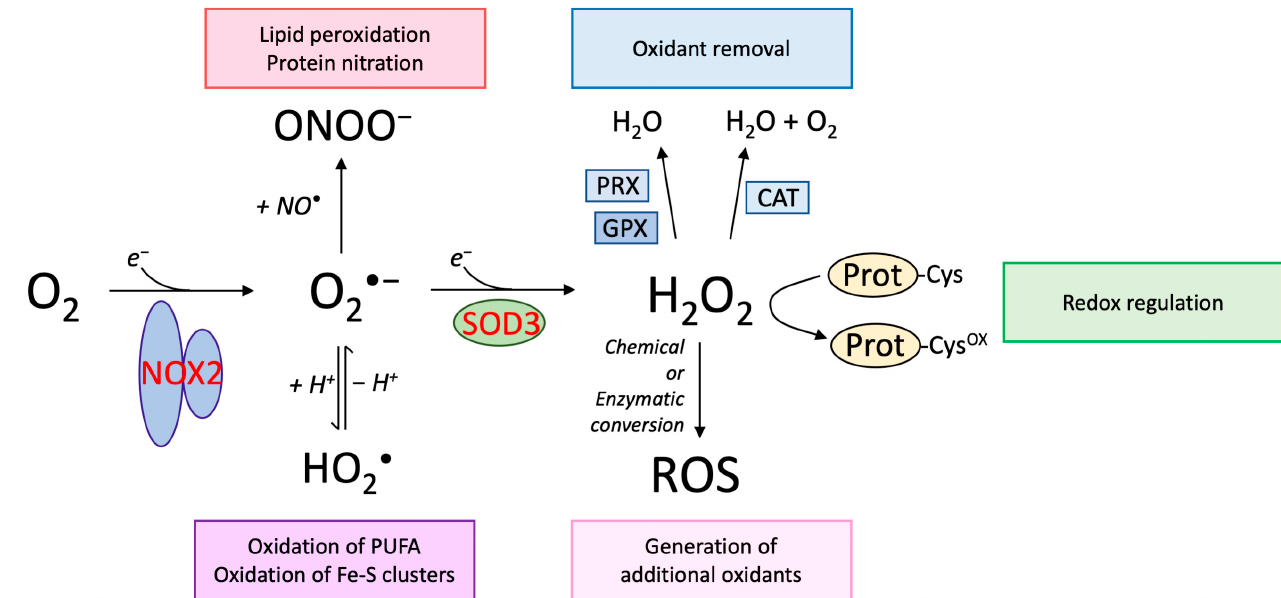
Figure 1. Biological impact of superoxide and hydrogen peroxide. The univalent reduction of molecular oxygen (O 2 ) generates the superoxide radical (O 2 •− ) and is enzymatically catalyzed by the NOX protein family, including NOX2. In biological systems at a physiological pH, superoxide is in equilibrium with the perhydroxyl radical, representing the protonated form of superoxide. Although the perhydroxyl radical only represents below 1% of superoxide at neutral pH, it is likely that this radical mediates some of the damaging impact of superoxide, indicated to include oxidation of polyunsaturated fatty acids (PUFA) and Fe-S clusters in proteins. Superoxide also participates in a very fast reaction with nitric oxide (NO • ), which is also a radical. The reaction generates peroxynitrite (ONOO − ), which supports oxidative reactions including lipid peroxidation and protein nitration. Hydrogen peroxide (H 2 O 2 ) is generated by the univalent reduction of superoxide, a process that may proceed spontaneously or catalyzed by superoxide dismutase enzymes, including SOD3. Hydrogen peroxide is not a radical and express in general a low propensity to react with biomolecules. The oxidant may be removed by peroxiredoxins (PRX) and glutathione peroxidases (GPX), both expressed as distinct isoforms in cellular compartments. Moreover, catalase (CAT) present in peroxisomes is also capable of removing hydrogen peroxide. Specific redox-sensitive proteins display highly reactive cysteine residues (Prot-Cys) that may be oxidized by H 2 O 2 to regulate biological activity (Prot-Cys ox ), a process referred to as redox regulation. Hydrogen peroxide may also fuel the formation of other oxidants established by chemical or enzymatic conversion. See main text for further details.